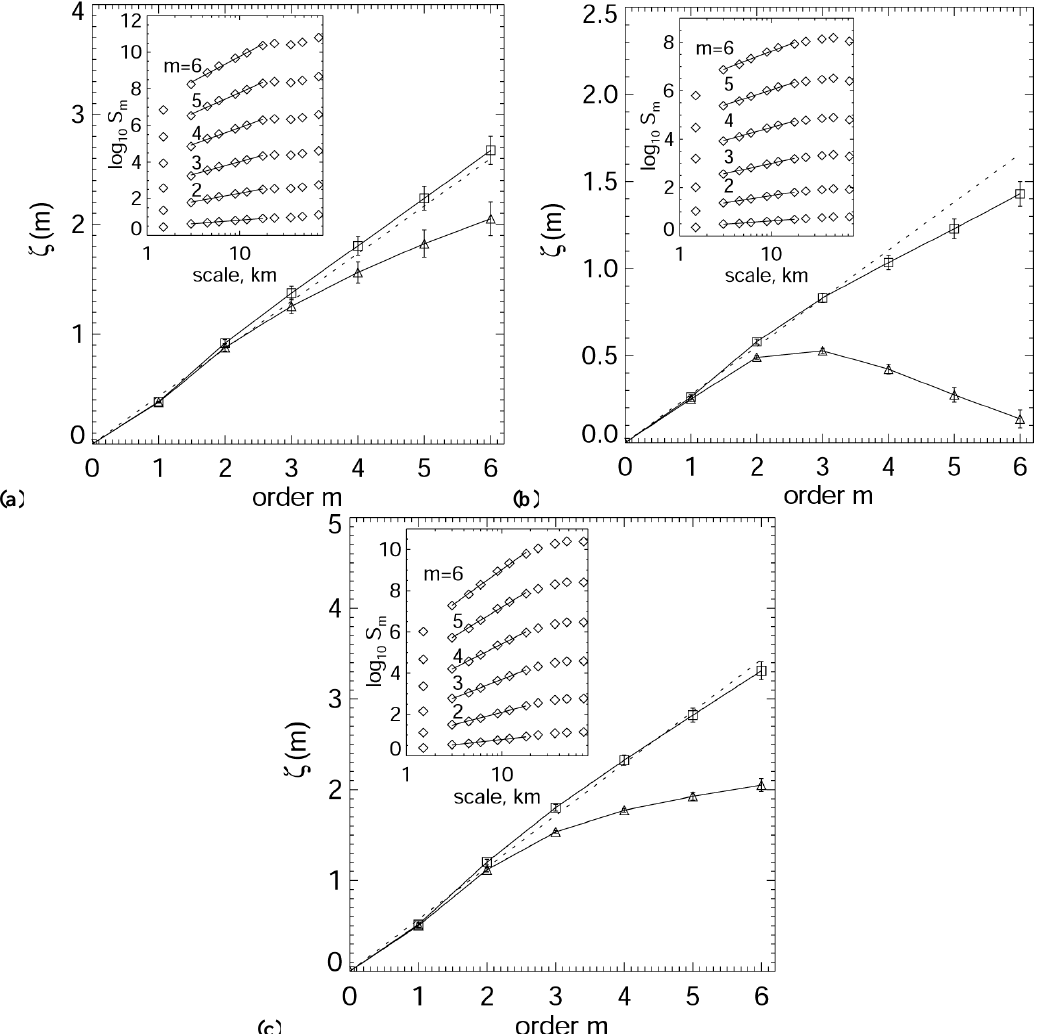
Fig. 7. Exponents of conditioned (squares) and unconditioned (triangles) generalized structure function as a function of the order of m for auroral intensity fluctuation in 20-s interval starting from: (a) 22:26:20; (b) 23:54:20; (c) 00:10:20. Insets: conditioned structure function S m of orders m =1-6; solid lines are the least-squares power-law